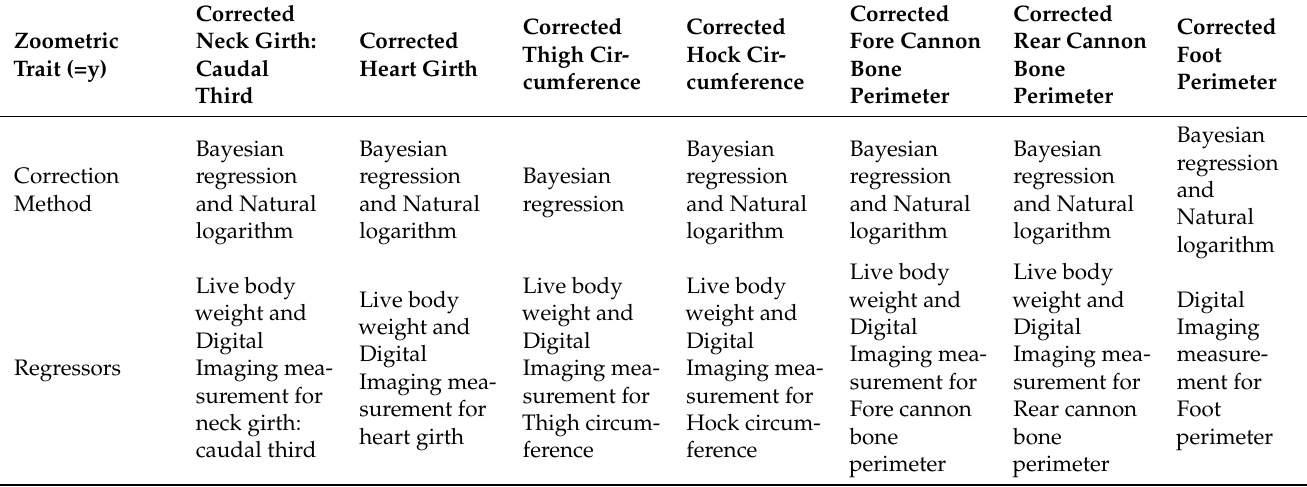
Table 4. Bayes factor model summary for correction models comprising digital measurements and live body weight, except for foot perimeter, for which only digital measurement was used as a regressor, to estimate for on-field zoometric measurements in Canarian